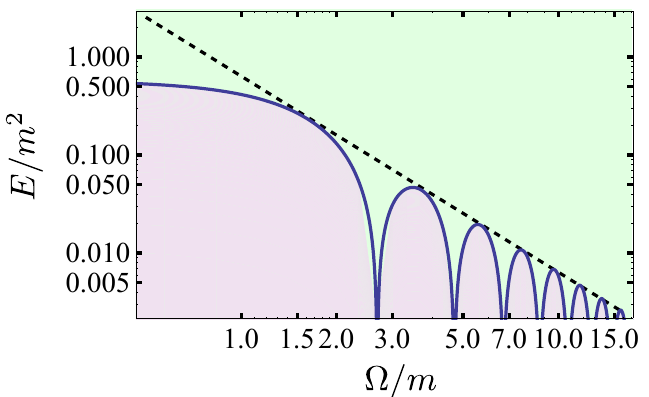
Figure 7 . Frequency dependence of the AC-Schwinger limit shown on a log-log plot. The solid curve represents the AC-Schwinger limit. The dashed line is E=m 2 = 2